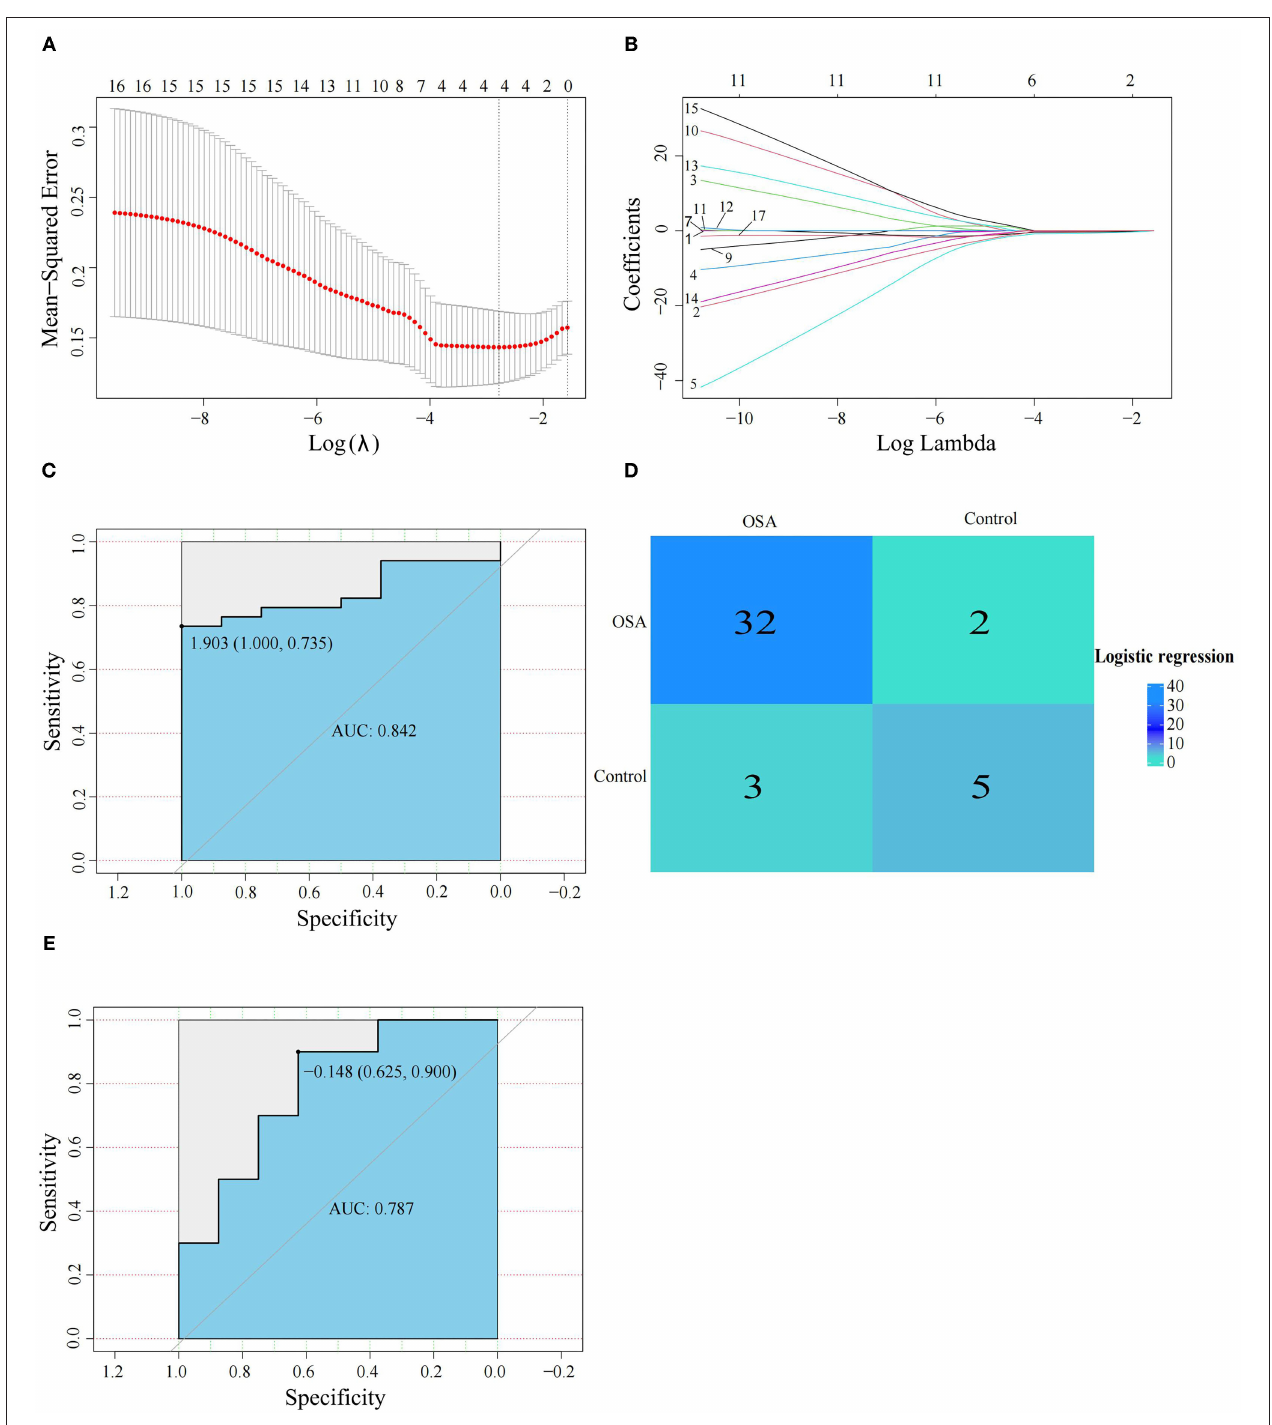
FIGURE 6 | Establishment and verification of the lasso model. (A,B) The lasso algorithm was used to screen the gene signature in OSA. (C) The diagnostic performance of the lasso model by ROC curve analysis in GSE135917. (D) Confusion matrix of GSE135917 using the lasso model. (E) Verification of the diagnostic performance of the lasso model by ROC curve analysis in